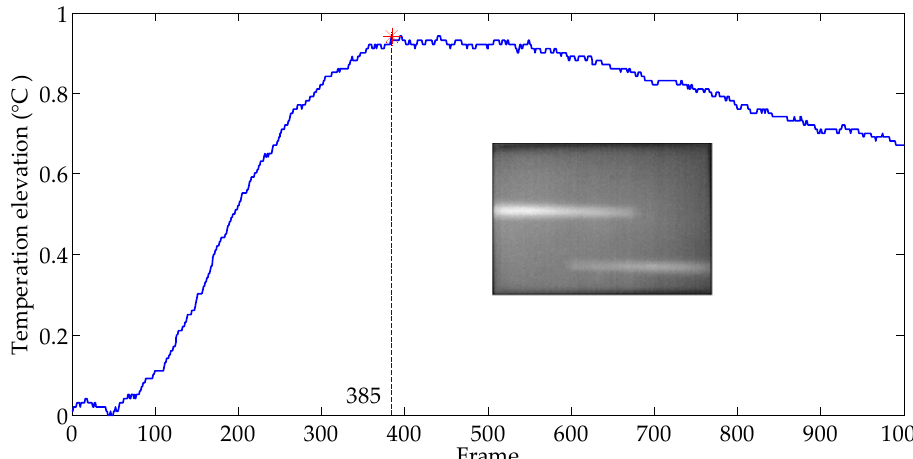
Figure 27. The curve of average temperature elevation over time and the acquired frame image.